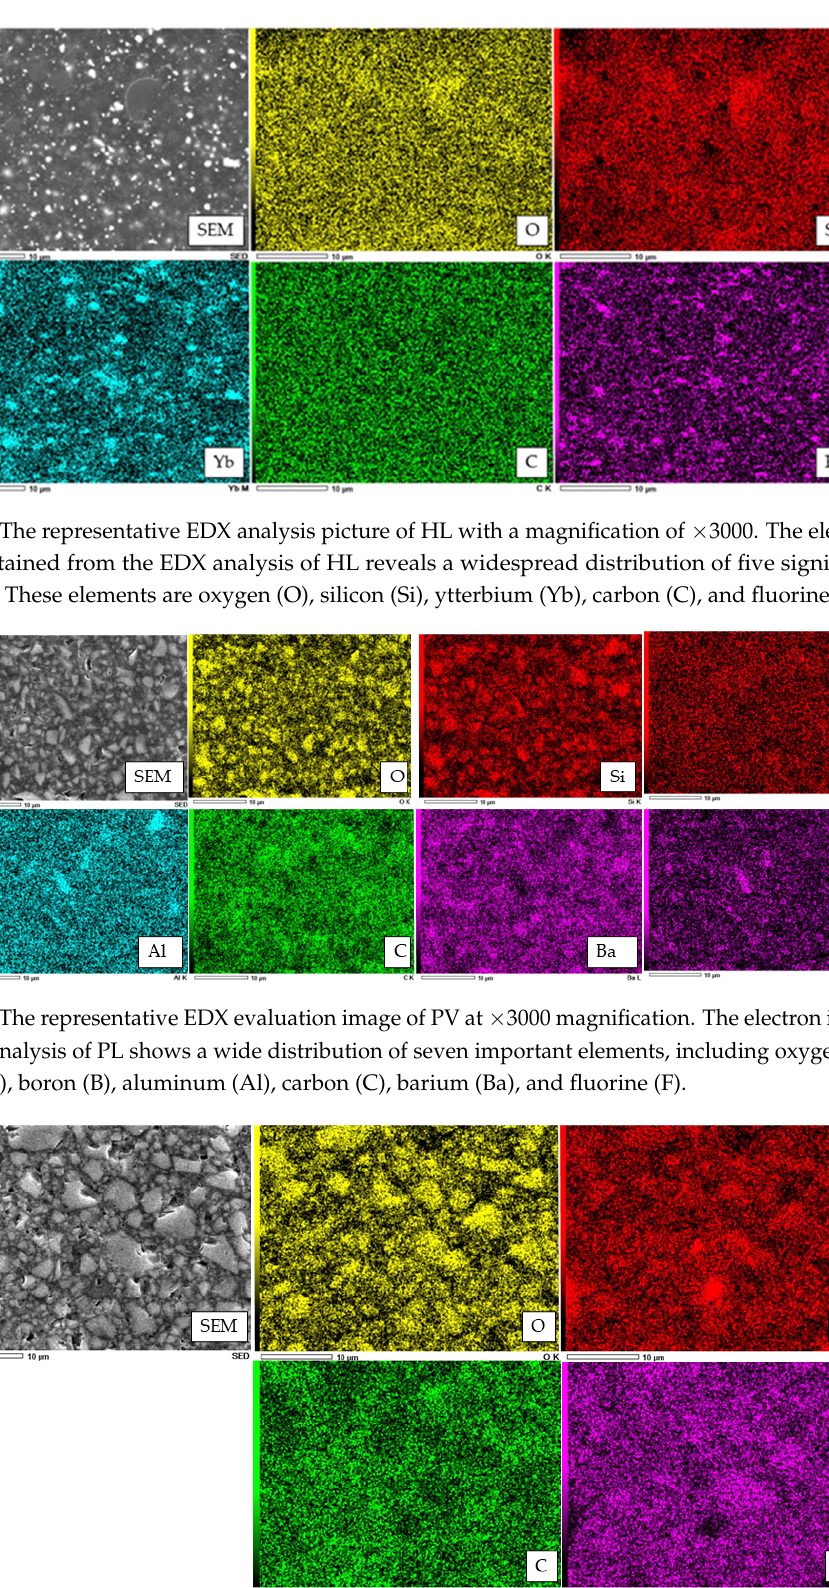
Figure 5. Elements identified by EDX spectroscopy microanalysis for novel experimental HL resin cement, PV resin cement, and AP resin composite.